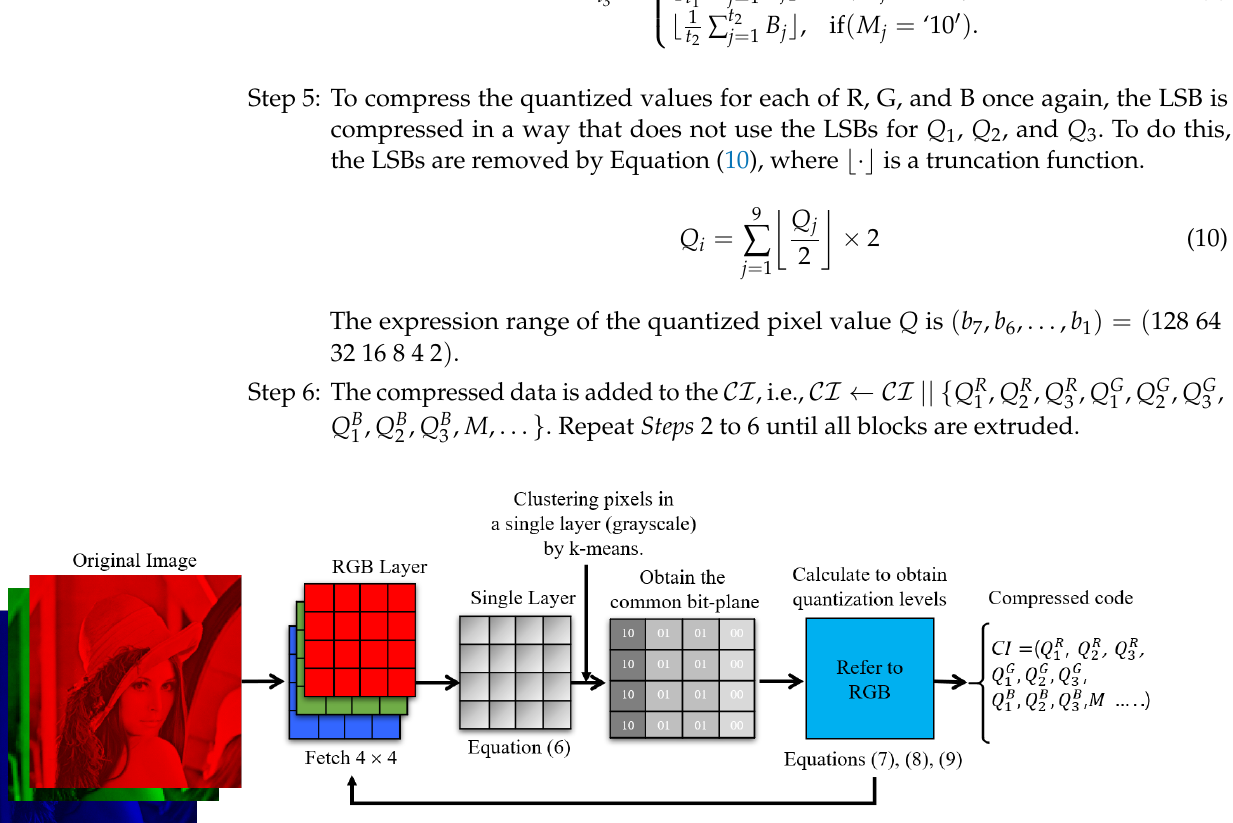
Figure 2. The proposed color AMBTC generation